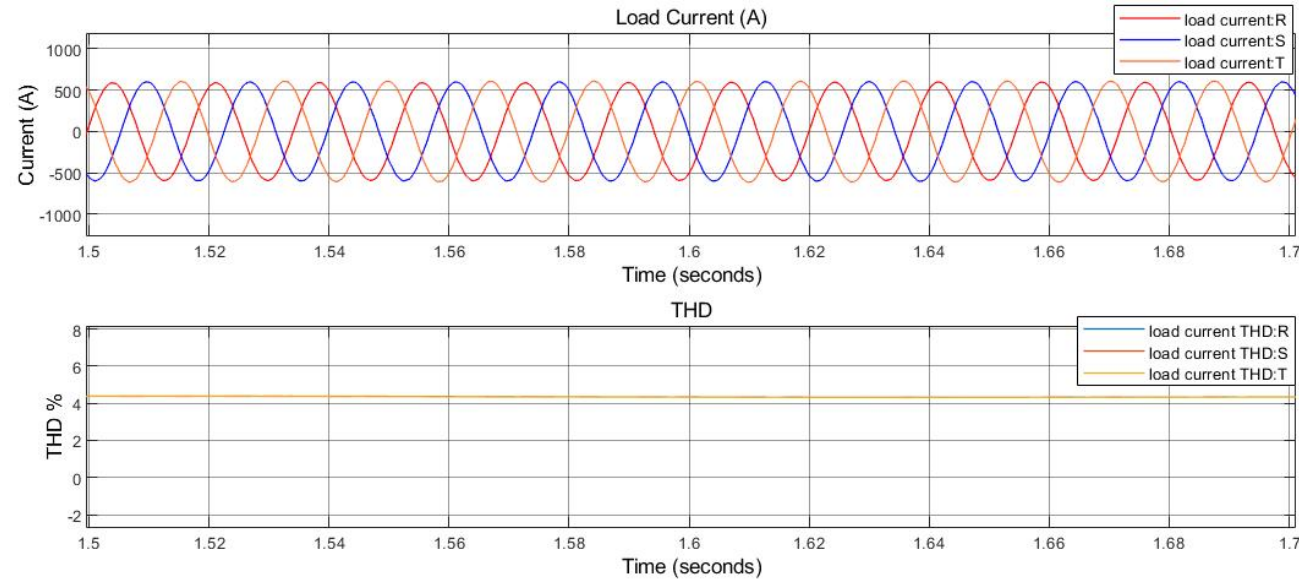
Figure 22. Load current and THD during simulation non ‐ linear load on the load side using hyste ‐ resis.